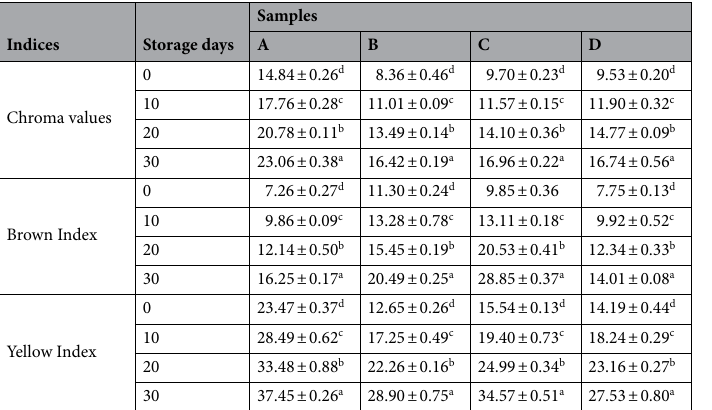
Table 3. Changes in yak butter powders chroma values, brown index, and yellow index during storage. Data are represented as mean ± standard deviation. “a,b,c,d” indicate significant differences between yak butter powders at p <